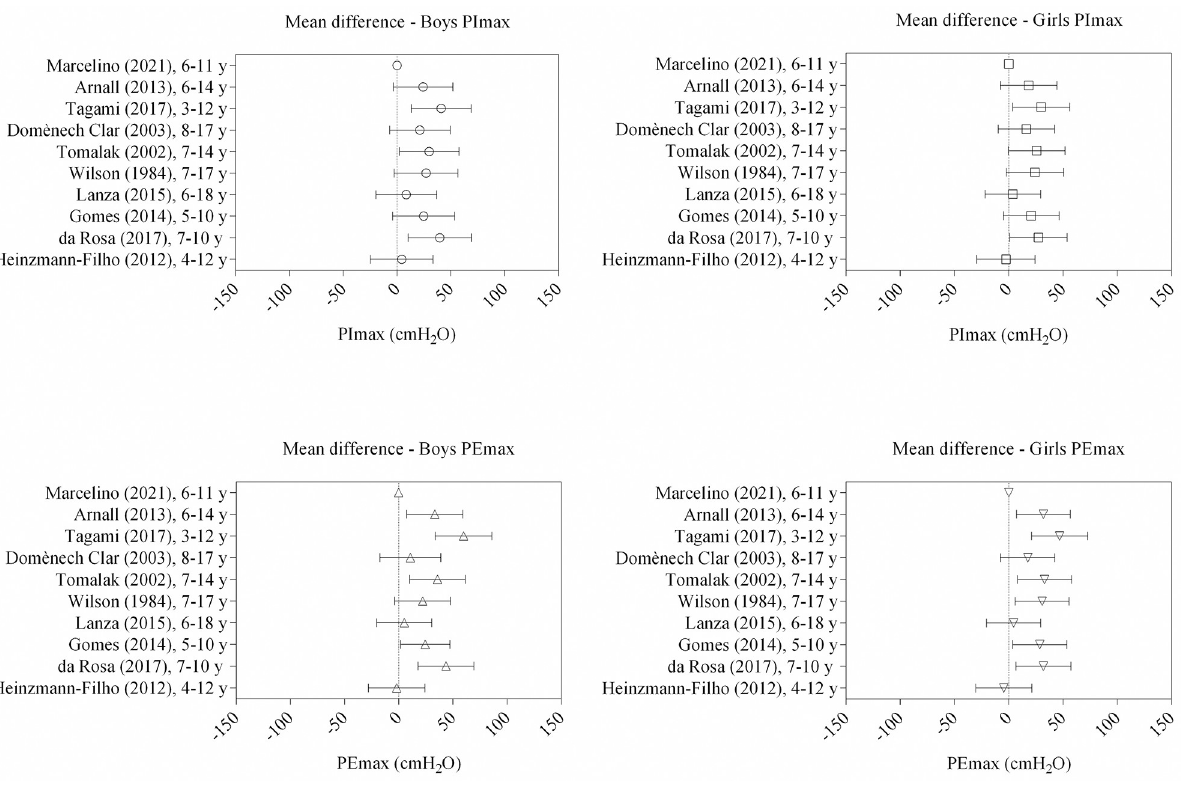
Fig 2. Mean difference between maximum respiratory and expiratory pressures (PImax and PEmax, respectively) found in the present and previous studies, according to sex; y =